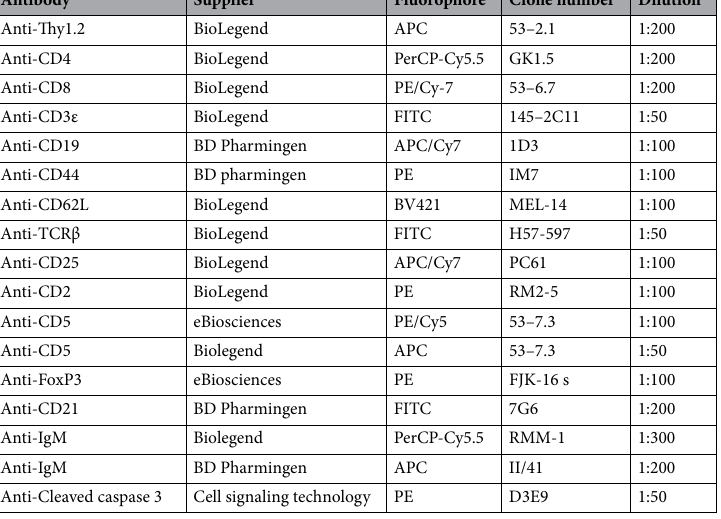
Table 1. Flow cytometry